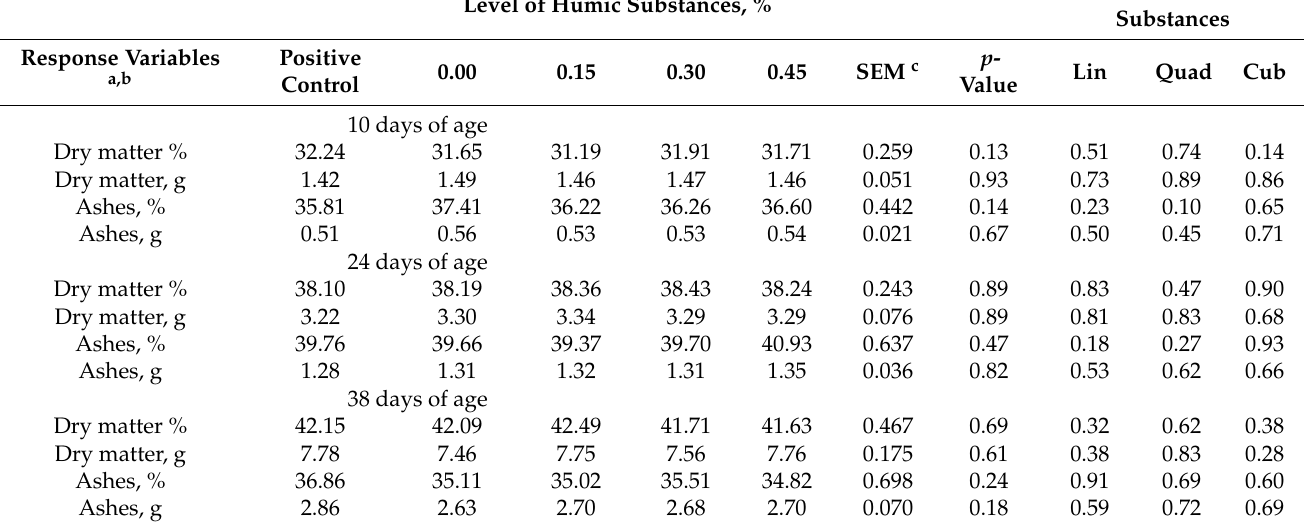
Table 4. Tibia dry matter and ashes content of broilers added with increasing levels of humic substances in the feed, probability level, and type of effect associated with humic